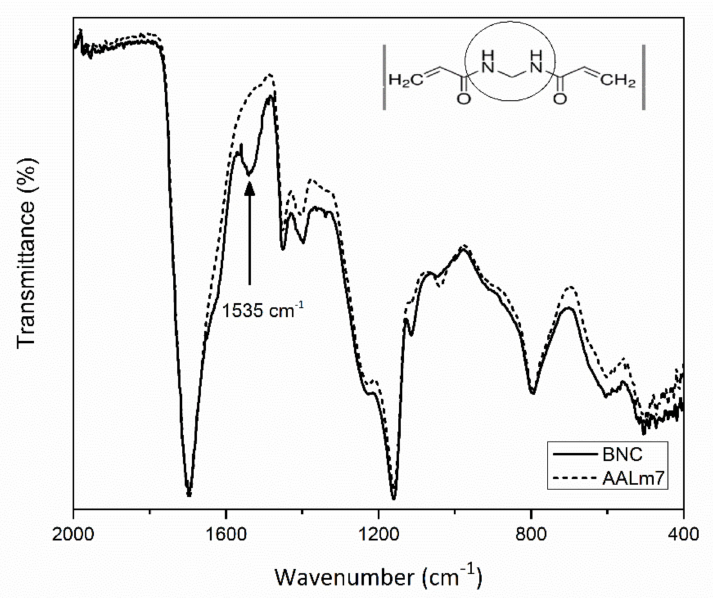
Figure 6. FTIR analysis of samples of BNC (straight line) and AALm7 (dash line) hydrogels. The spectrum of AALm7, corresponds to the sample of hydrogel with modified